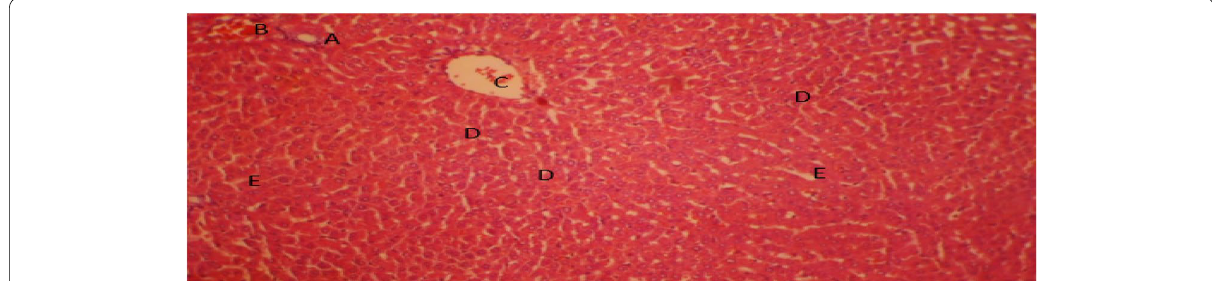
Fig. 3 Liver section of Control (Group 1) composed of: A , bile duct, B , portal vein, C , central vein, D , hepatocytes and E , sinusoids (H&E x